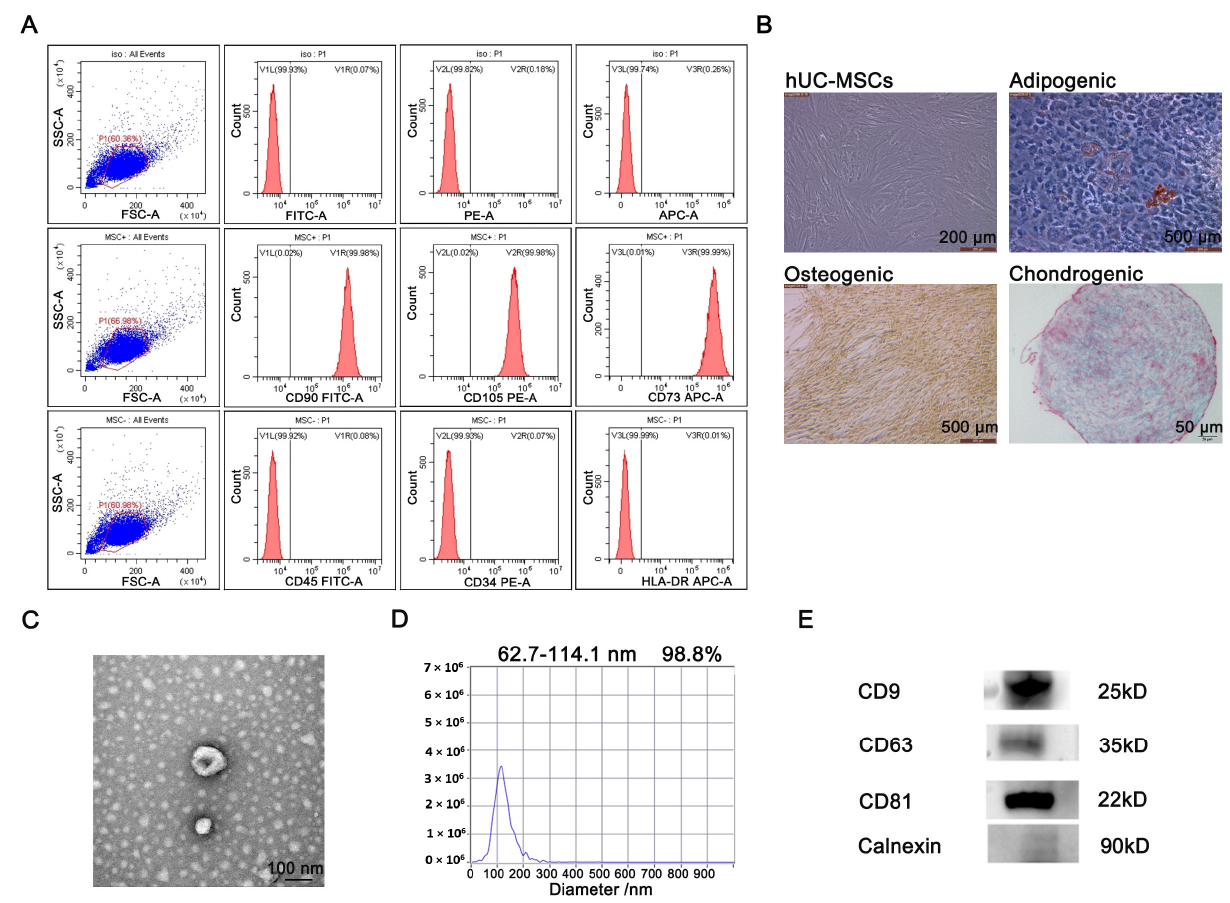
Figure 1. Identification and characterization of hUC-MSCs and secreted EVs. ( A ) Identification of surface marker proteins of hUC-MSCs by flow cytometry. ( B ) The differentiation ability of hUC-MSCs was evaluated by cell staining. ( C ) The morphological characteristics of the EVs were observed by TEM. ( D ) The particle size distribution range of the EVs was analyzed by NTA. ( E ) The surface markers of EVs were analyzed by Western